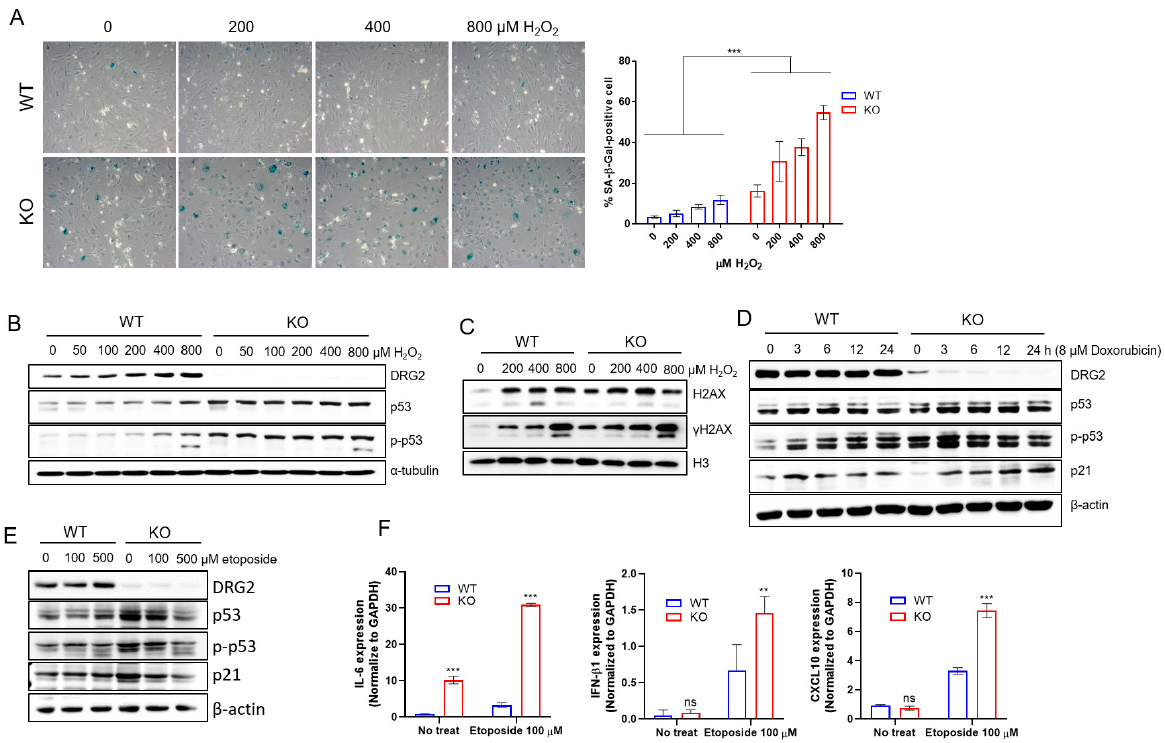
Figure 4. Enhanced oxidative stress-induced DNA damage and senescence in DRG2 deficient endothelial cells. ( A – C ) mLECs from wild-type and DRG2 − / − mice were exposed to H 2 O 2 at the indicated concentrations for 6 h. ( A ) Representative images of SA- β -gal-stained cells (original magnification 200 × ) with quantification of SA- β -gal-positive cells. The data are expressed as the mean ± SD (n = 5 in each group). *** p < 0.001. ( B , C ) Cells were analyzed by Western blot assay for the levels of ( B ) total and phosphorylated p53, and ( C ) γ H2AX. ( D ) mLECs from wild-type and DRG2 − / − mice were treated with 8 µ M doxorubicin for the indicated time and analyzed by Western blot assay for the levels of total and phosphorylated p53, and p21. ( E ) mLECs from wild-type and DRG2 − / − mice were treated with indicated concentration of etoposide for 24 h and analyzed by Western blot assay for the levels of total and phosphorylated p53, and p21. All Western blot data were representative ones of more than two experiments. ( F ) mLECs from wild-type and DRG2 − / − mice were incubated for 6 h in the absence or presence of 100 µ M etoposide and analyzed by qPCR for levels of IL-6 , IFN- β 1 and CXCL10 . The data are expressed as the mean ± SD (n = 3 in each group). ** p < 0.005, *** p <